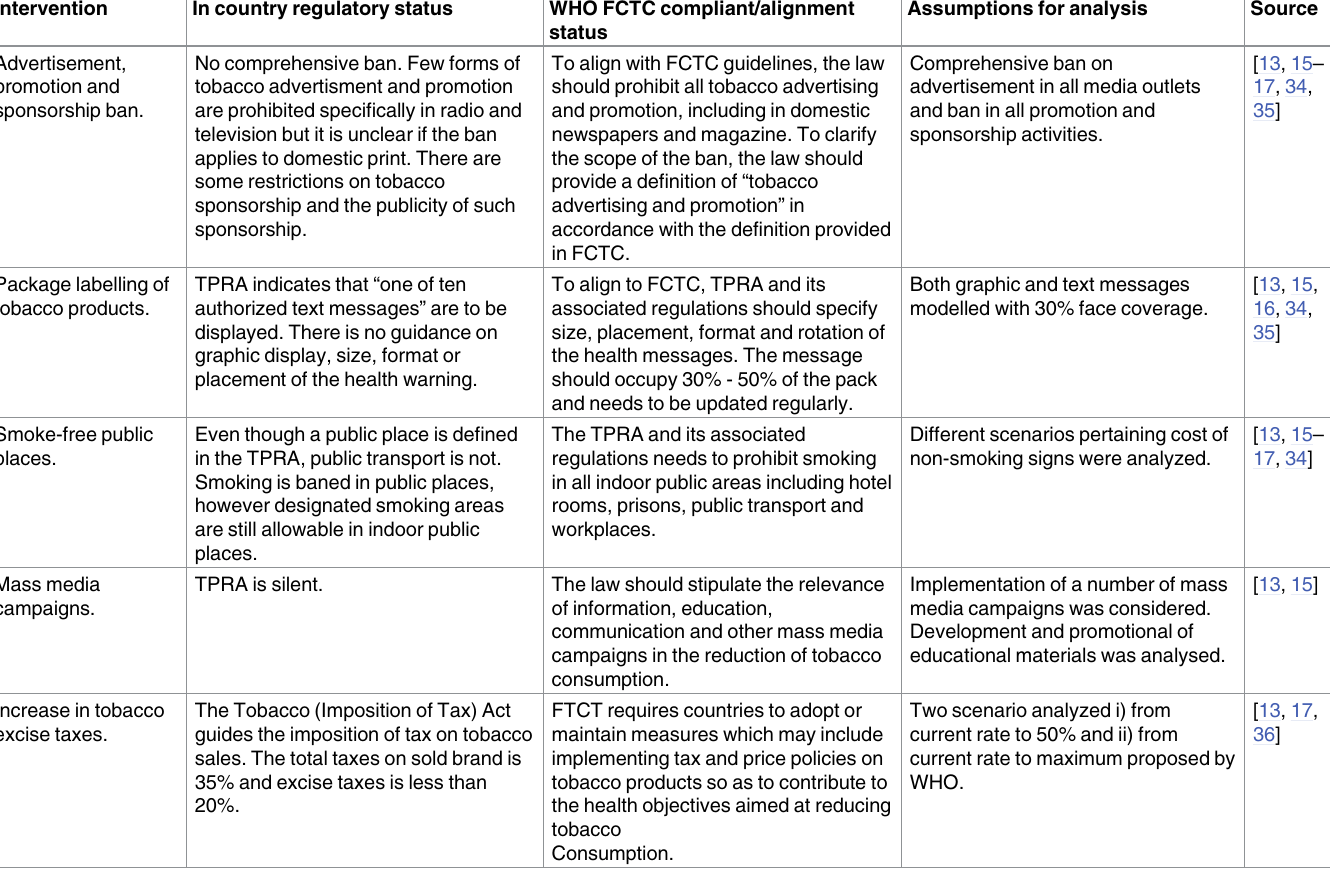
Table 4. Description of the tobacco control interventions analysed. Intervention In country regulatory